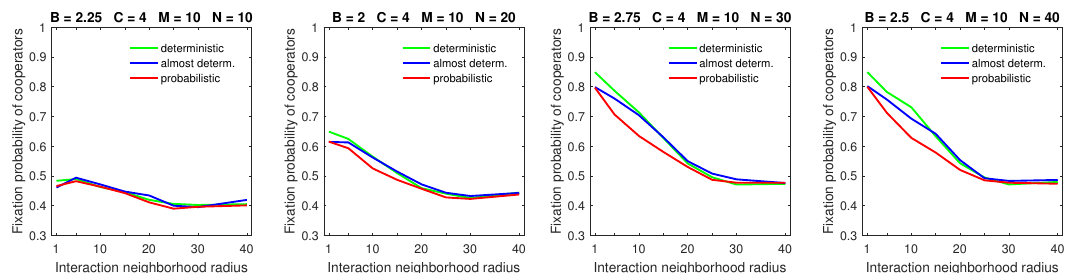
Figure 8. The (almost) deterministic dispersal pattern results in higher fixation probabilities of cooperators compared to the probabilistic dispersal pattern when the mobility rate is high. The advantage of deterministic dispersal is greater for small interaction neighborhoods and dense populations. In all graphs, R =